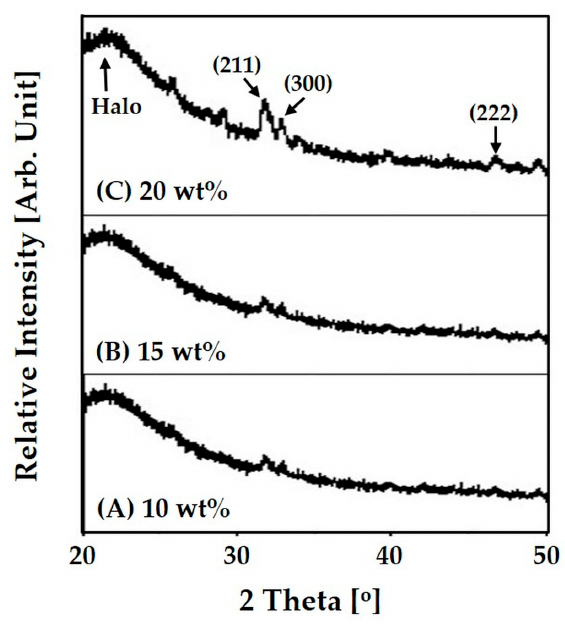
Figure 5. Representative X-ray diffraction (XRD) patterns of nanofibrous collagen/HA composite microsphere synthesized with different levels of HA: ( A ) 10 wt %; ( B ) 15 wt %; ( C ) 20 wt %.